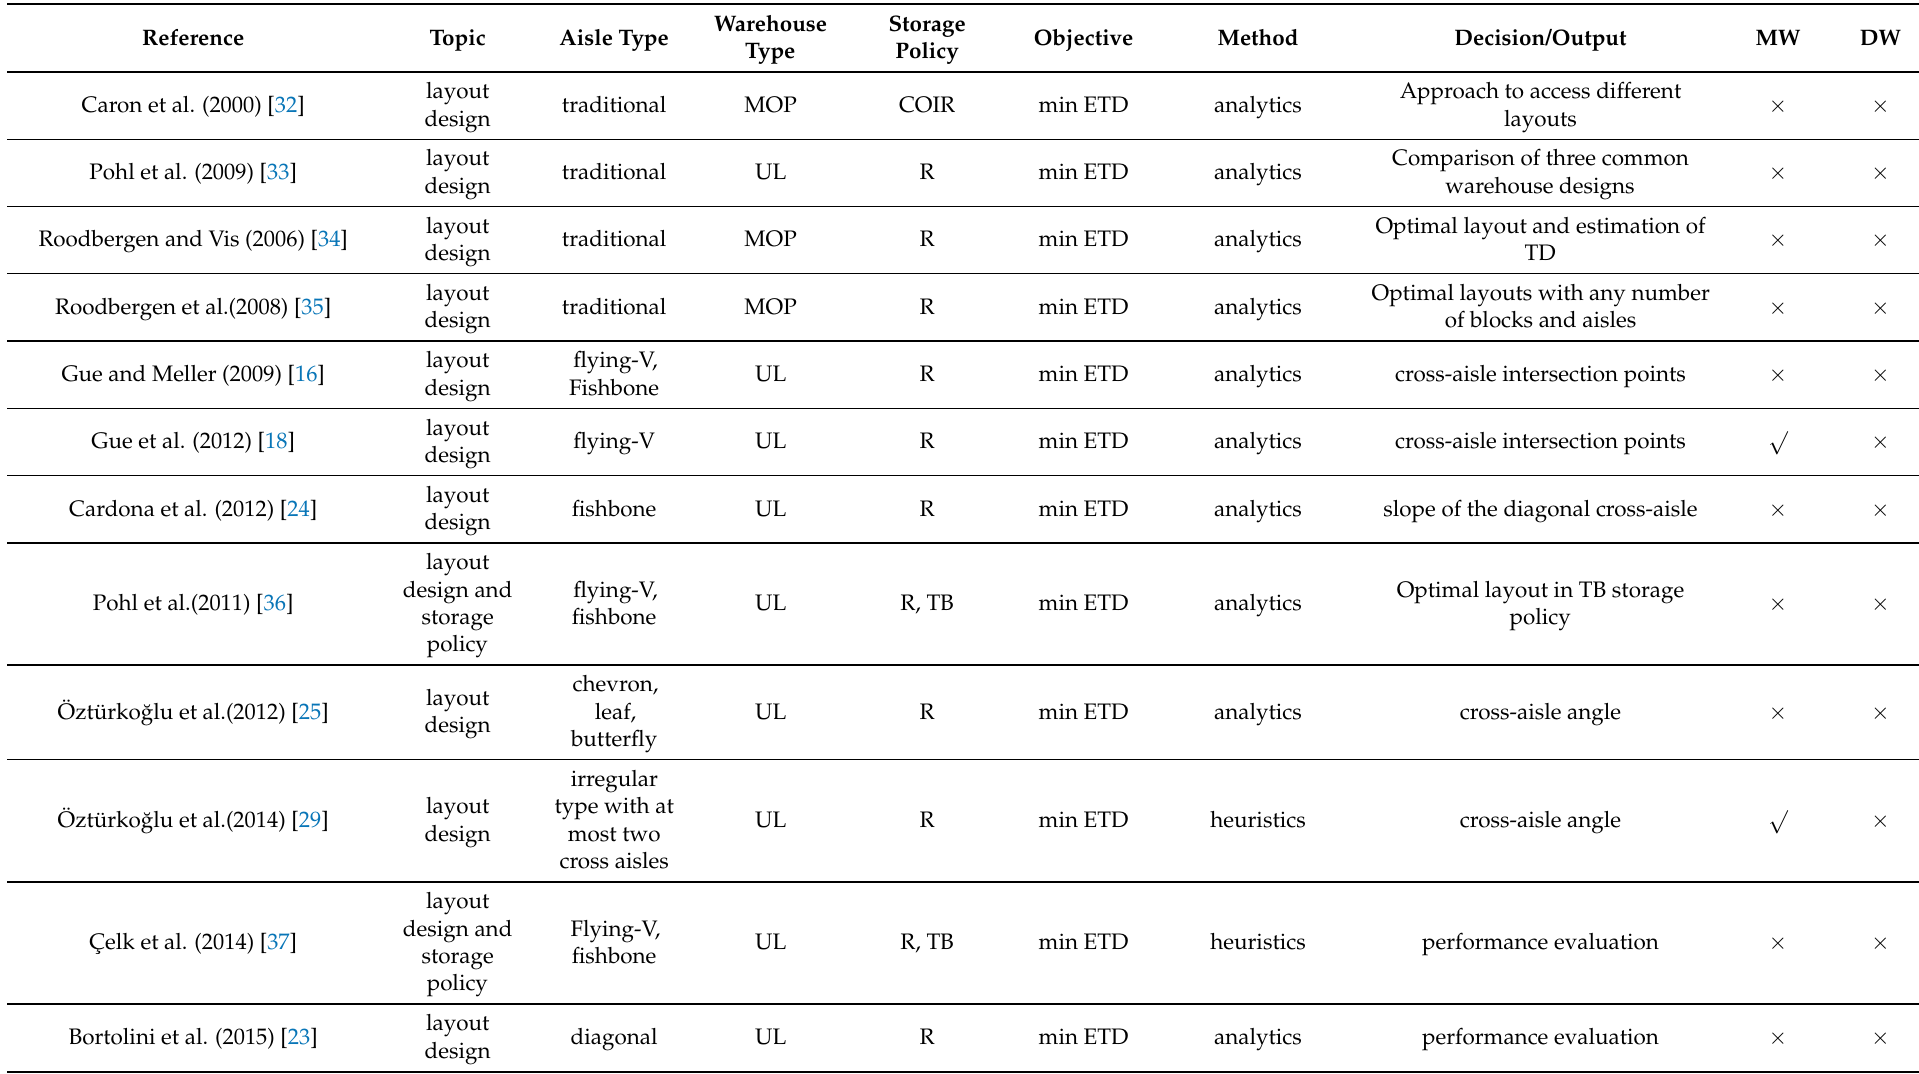
Table 1. Literature overview of warehouse design